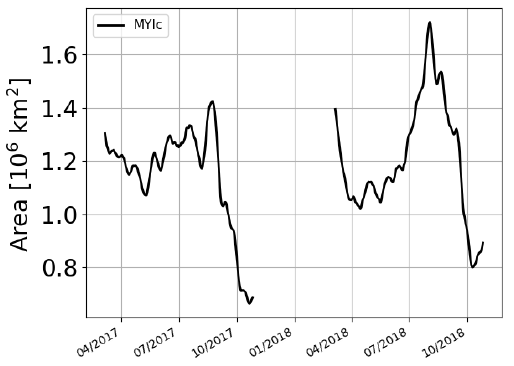
Figure 15. Area of corrected MYI, years 2017 and 2018, March to October, smoothed with a 11d moving